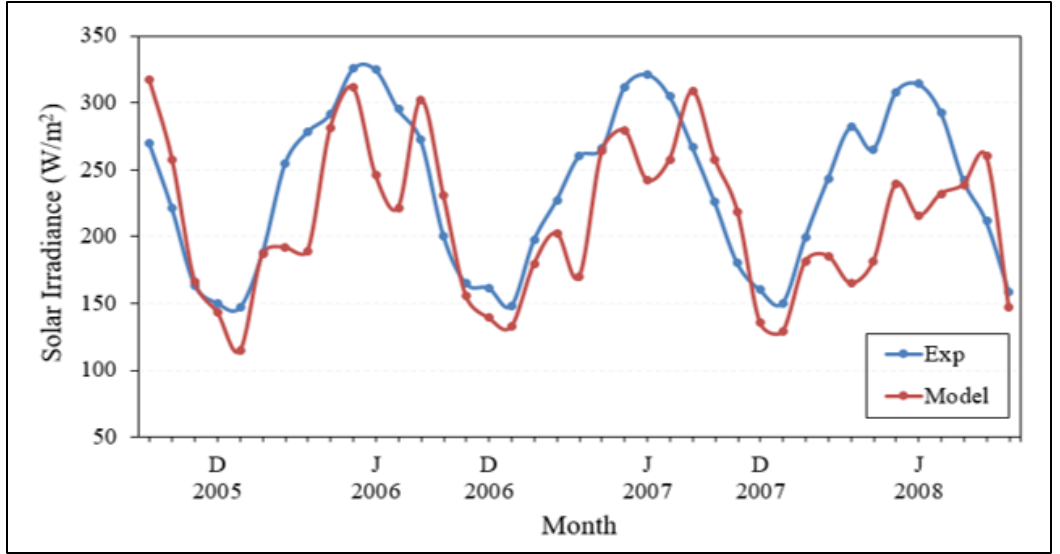
Figure 7. Model verification using experimental solar irradiance data collected in Dhahran (26.307° N, 50.146° E), Saudi Arabia during September 2005–November 2008.